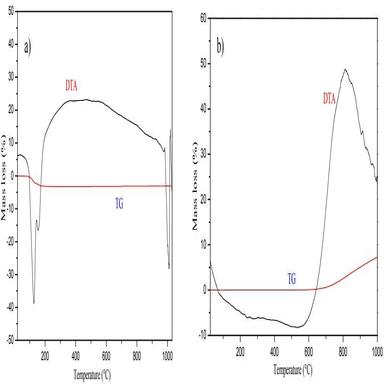
DTA/TG diagram for (a) as-prepared starting material and (b) after a heat treatment at temperature of 1500C. Black line - DTA; red line - TG.